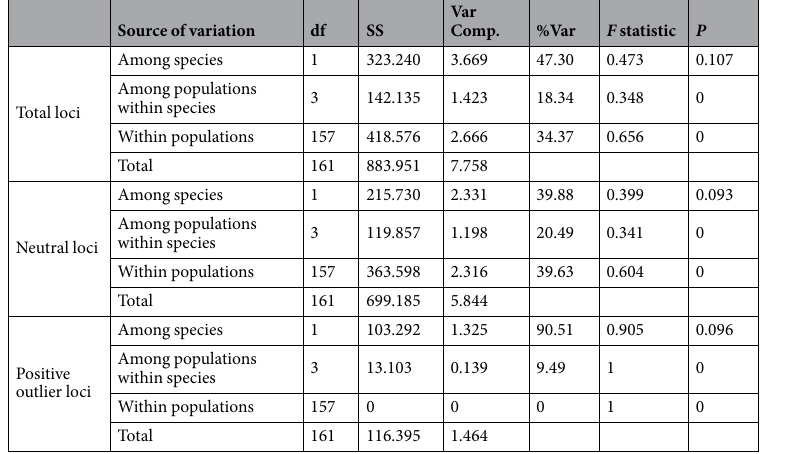
Source of variation df SS